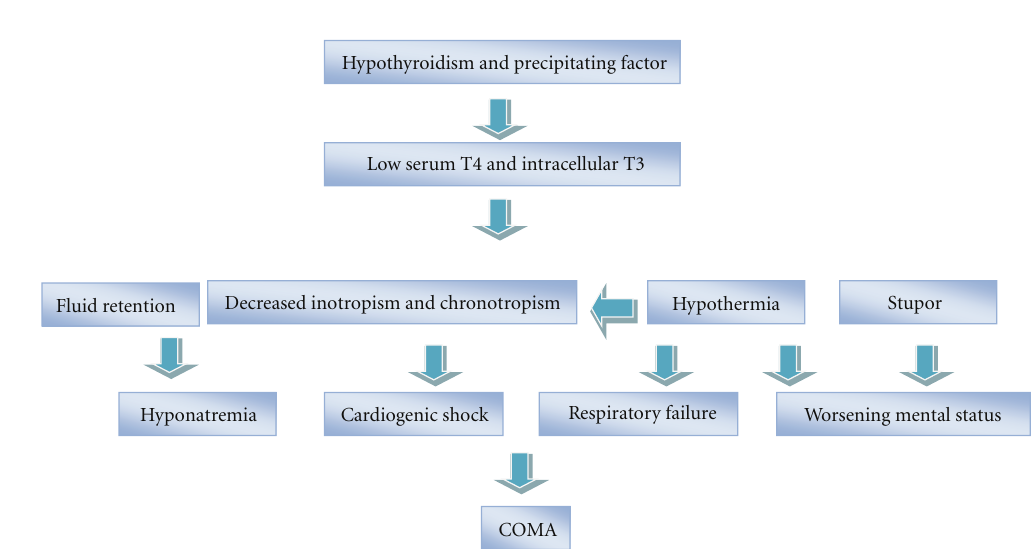
Figure 1: Pathogenesis of myxedema